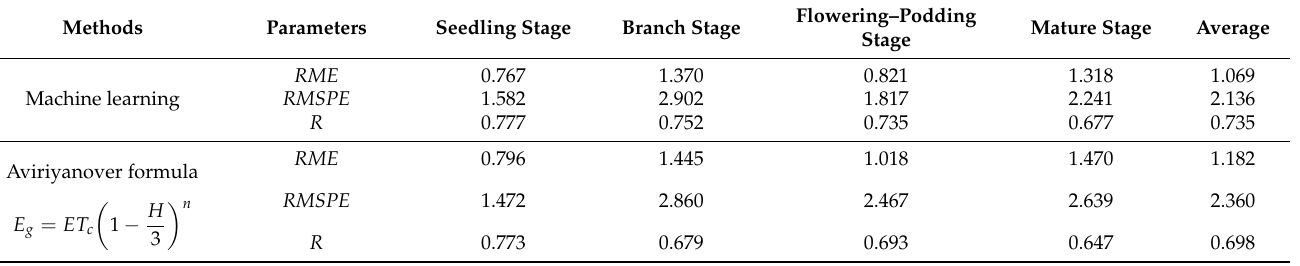
Table 5. Validation errors for groundwater contribution for the machine learning and formula